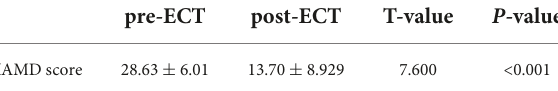
TABLE 2 Comparisons of the HAMD scoress between pre- and